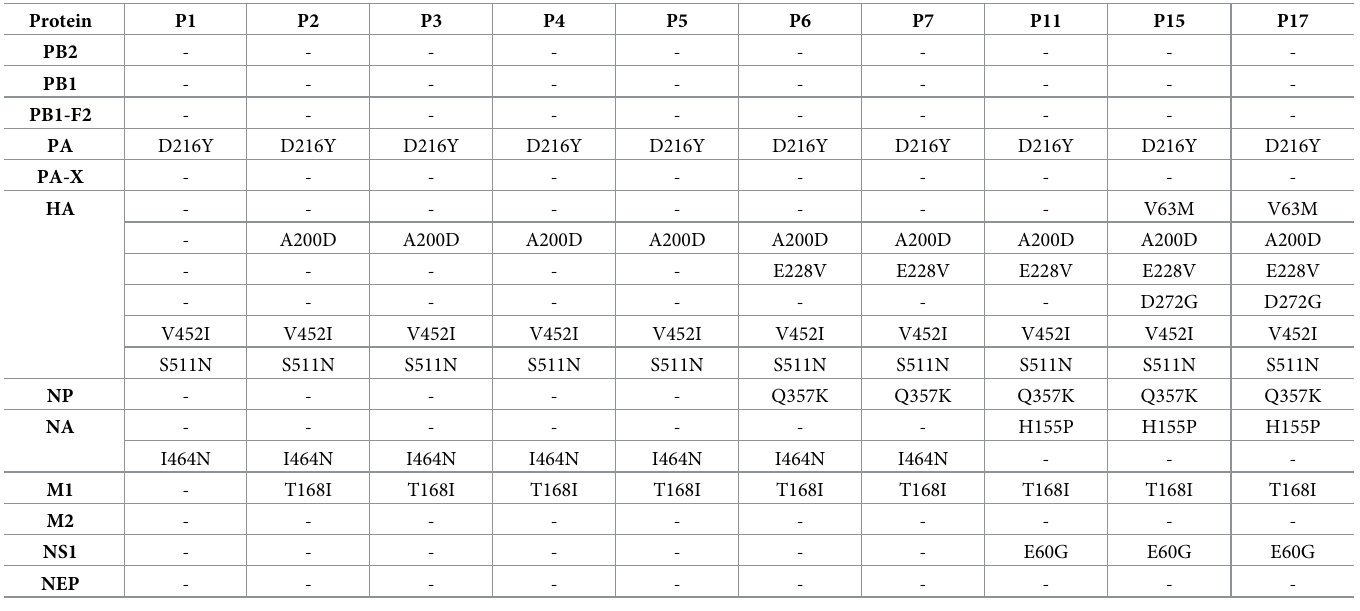
Table 2. Amino acid changes in the consensus H5N2 virus genomes across passages (P), compared to the original LPAI H5N2 virus. Protein P1